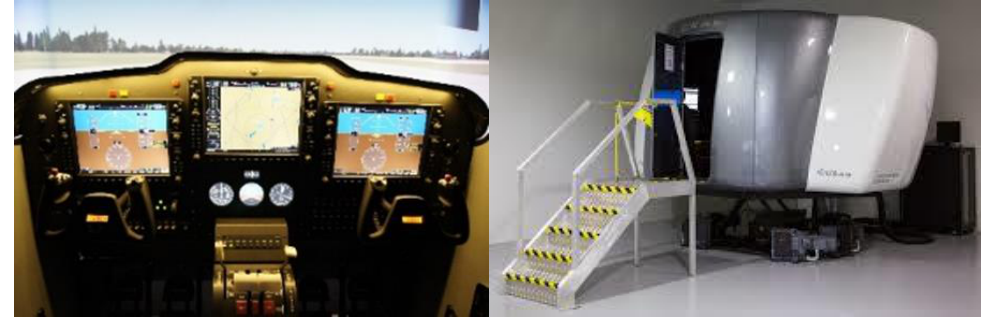
Figure 1. CKAS Motion Sim 5